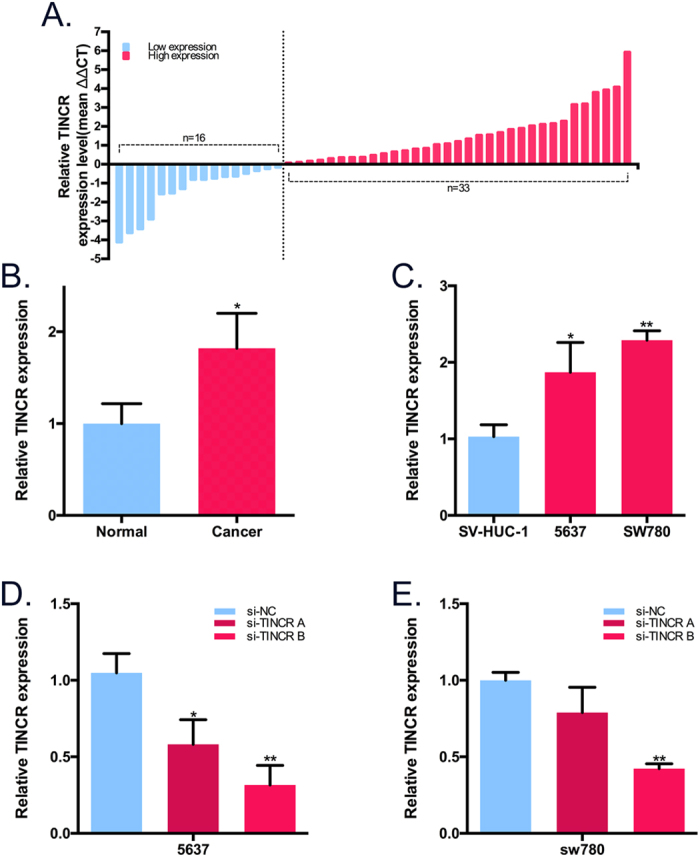
Expression of TINCR in BCa and expression change of TINCR after transfection of siRNAs performed by real-time qPCR.(A) Expression of TINCR expression was examined in 49 paired human BCa tissues and corresponding noncancerous tissues. Data are represented as ΔΔCt which are the normalized real-time qPCR cycle threshold (Ct) values of TINCR between cancer tissues and pair-matched noncancerous tissues, and defined as “<0” for low expression (n = 16) and “>0” for high expression (n = 33). (B) The relative expression level of TINCR was significantly higher in bladder cancer tissues compared with matched normal tissues (paired T test). Bar: mean ± SEM; *P < 0.05. (C) Compared with SV-HUC-1, the relative expression level of TINCR was overexpress significantly in BCa cell lines 5637 and SW780. Bars: mean ± SD; *P < 0.05, **P < 0.01. (D,E) TINCR expression level following the treatment of 5637 and SW780 cells with siRNAs. The si-TINCR B could significantly knock down TINCR in both 5637 and SW780. Bars: mean ± SD; *P < 0.05, **P < 0.01.